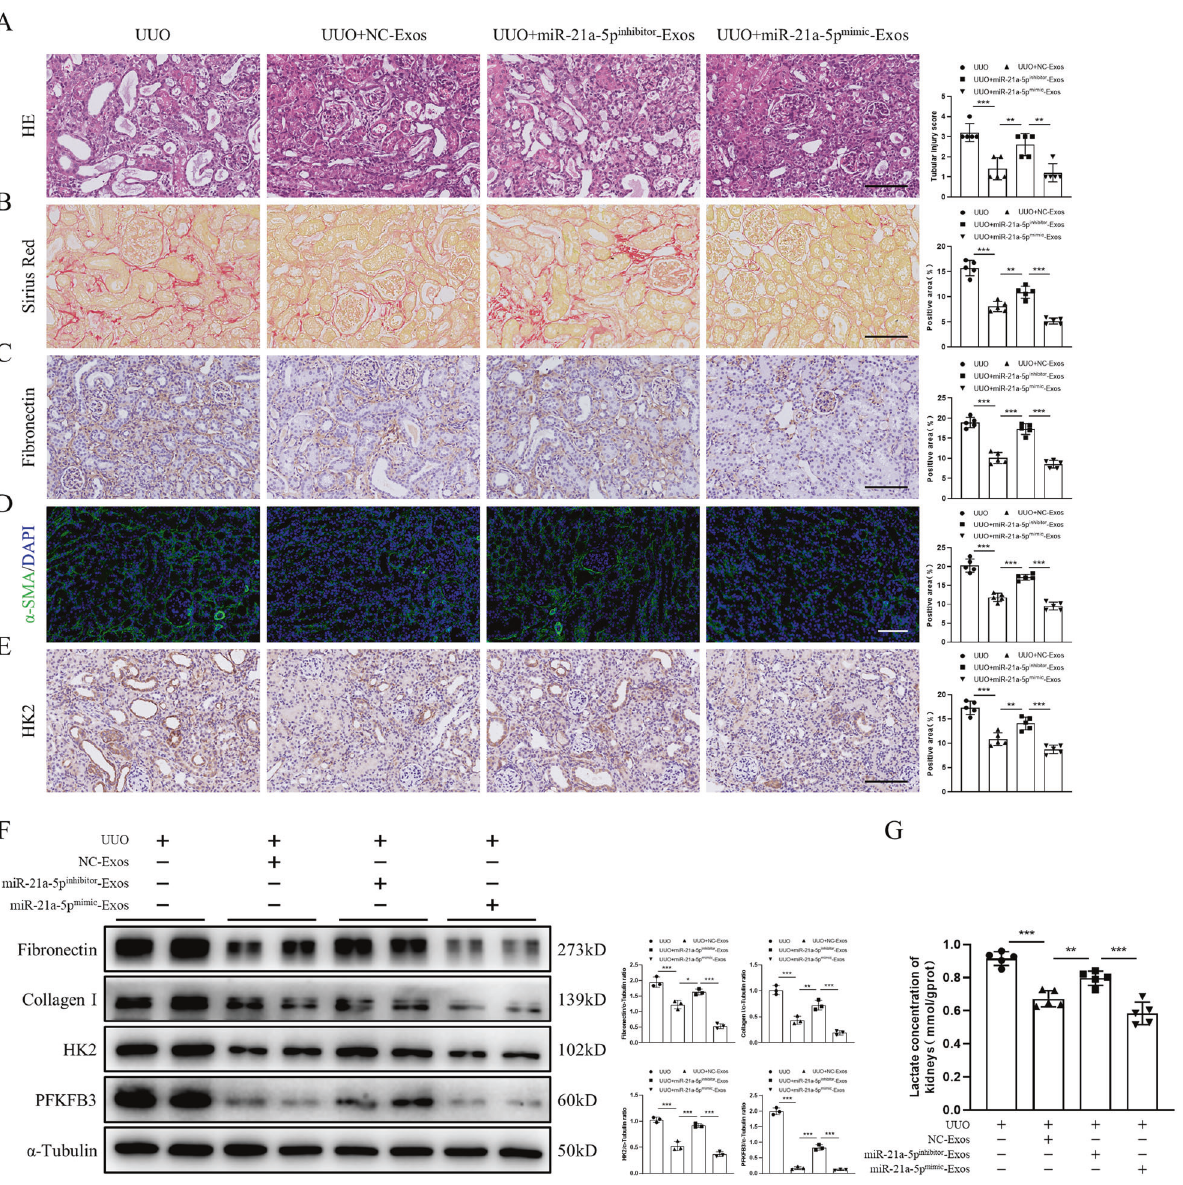
staining ( n = 5 mice per group; scale bar = 100 μ m). B Deposition of collagenous fi bers in the renal interstitium was evaluated by Sirius Red staining ( n = 5 mice per group; scale bar = 100 μ m). C Immunohistochemistry staining of fi bronectin in kidney tissues ( n = 5 mice per group; scale bar = 100 μ m). D Immunohistochemistry staining of α -SMA in kidney tissues ( n = 5 mice per group; scale bar = 100 μ m). E Immunohistochemistry staining of HK2 in kidney tissues ( n = 5 mice per group; scale bar = 100 μ m). Representative images from one experiment out of three are shown. F The expression of fi bronectin, collagen I, HK2 and PFKFB3 in kidney tissues was assessed by western blot analysis ( n = 3 mice per group). G The lactate concentration of kidney tissue homogenates was quanti fi ed by a lactate assay kit ( n = 5 mice per group). Data are presented as the mean ± SD from three independent experiments. * p < 0.05, ** p < 0.01 and *** p <